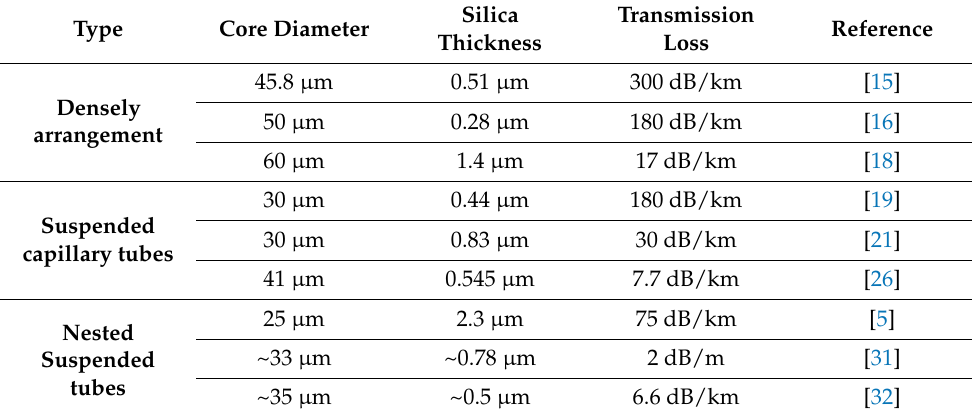
Table 1. Parameters in various